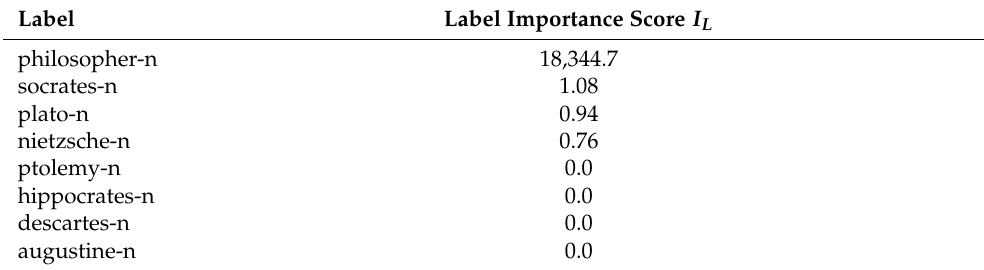
( respect-n , affection-n , friendship-n , 1